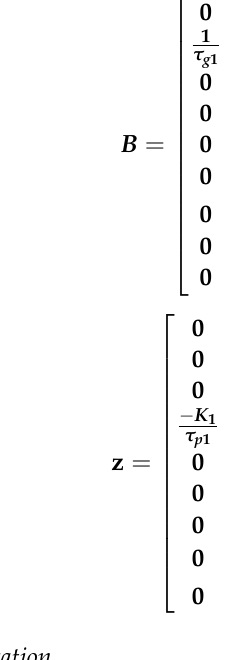
Table 1. Nomenclatures of the two-area power system.